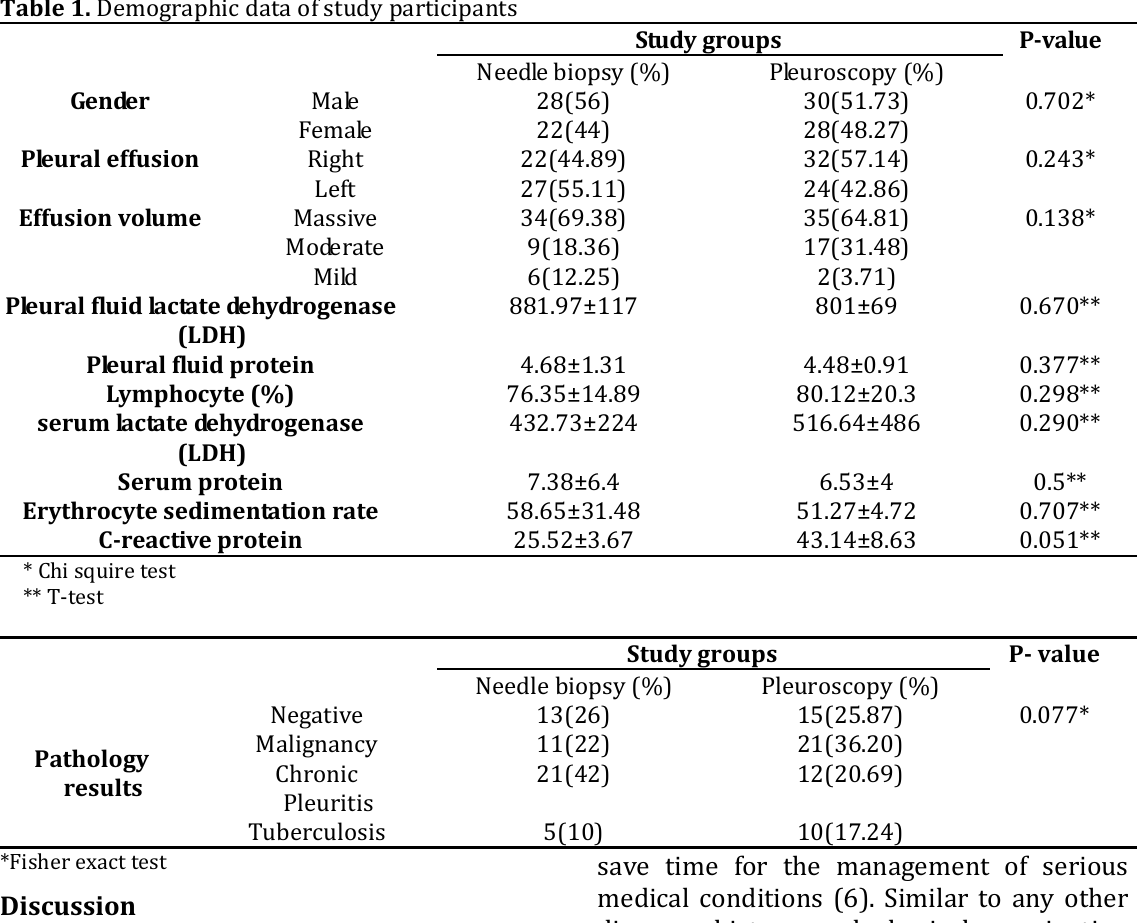
Table 1. Demographic data of study